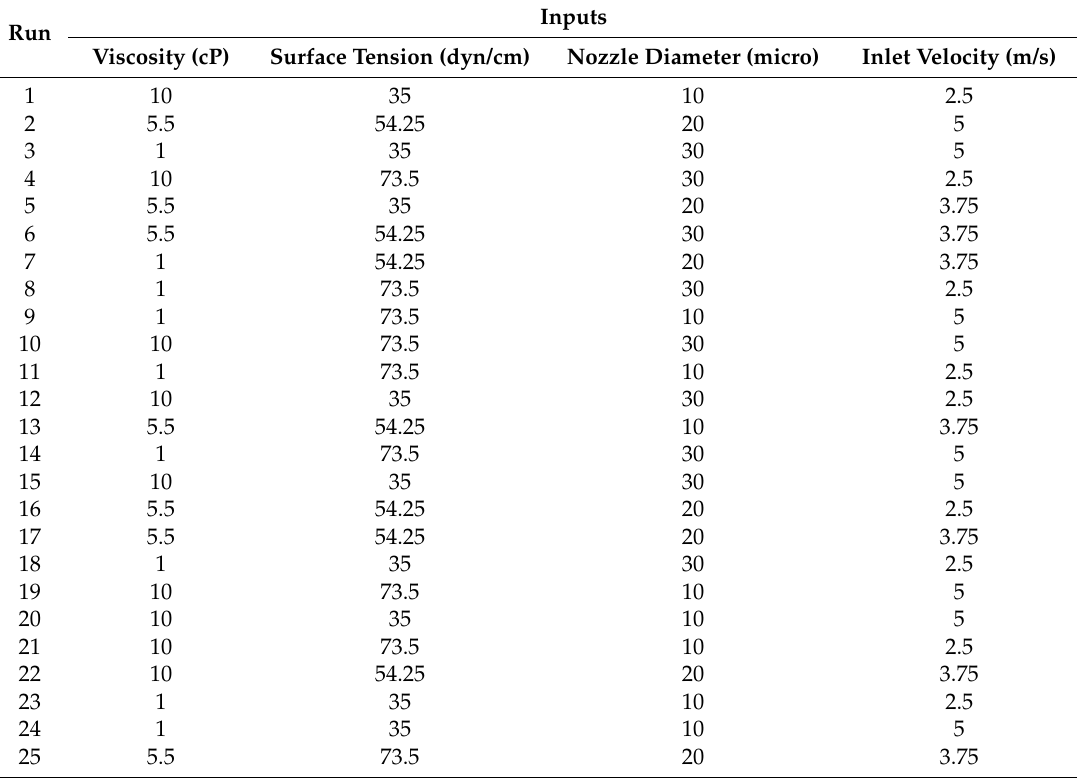
Table 3. Face centred design with corresponding factors and